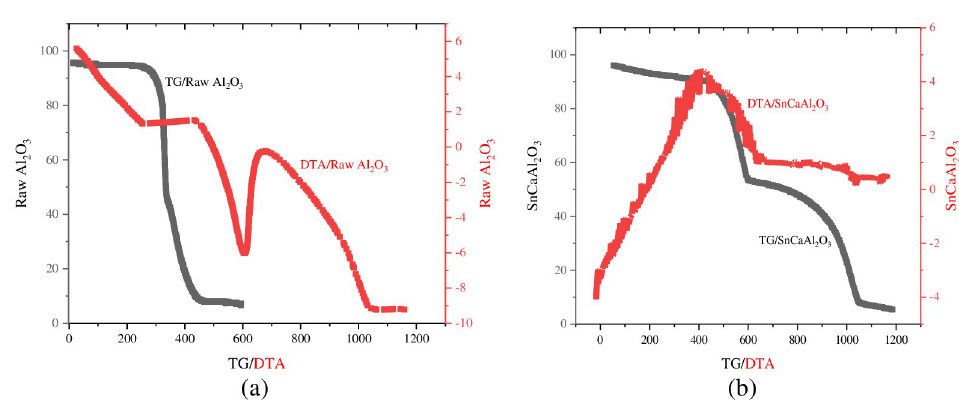
Fig 2. TG/DTA of (a) Al 2 O 3 , and (b) SnCaAl 2 O 3